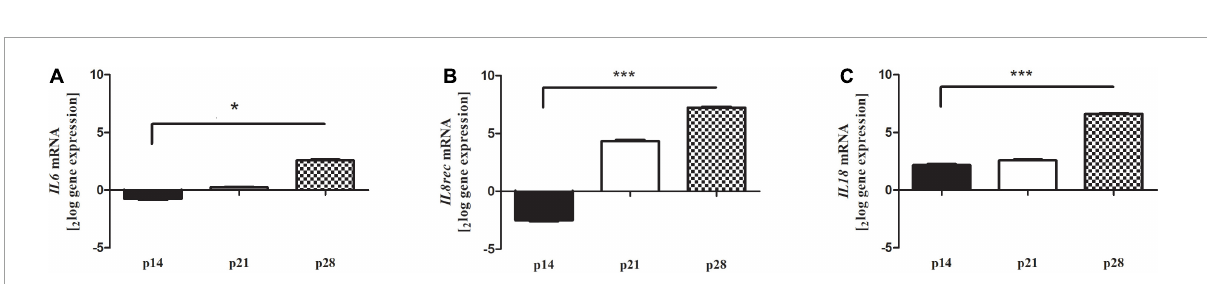
FIGURE4 (A) IL6, (B) IL8R and (C) IL18 transcript expression in retinal extracts. Total RNA was used to generate cDNA for real time PCR analysis. Histograms show a significant upregulation at p28 for all targets investigated. Significant differences are shown as * p < 0.01, *** p < 0.0005, REST analysis; Reeler vs . WT). Data are 2logFC transcript expression (mean ± SEM, Reeler vs.